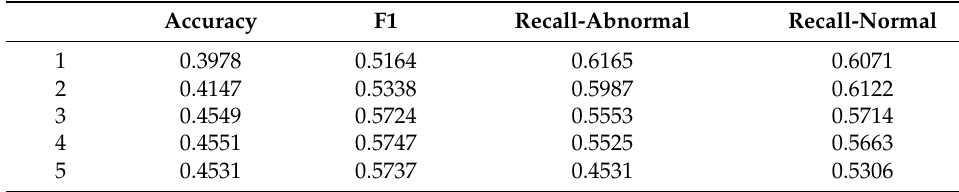
Figure 6. The MCRNN training loss curve with different sampling ratios. Table 3. Results for sampling ratios = 1:1 with k = 5.